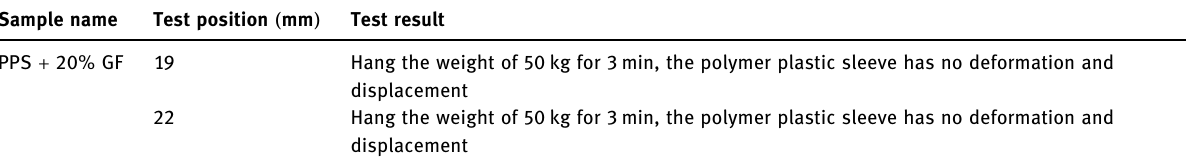
Table 1: Test results of pull - o ff experiment of PPS plastic sleeve on spanner tool surface Sample